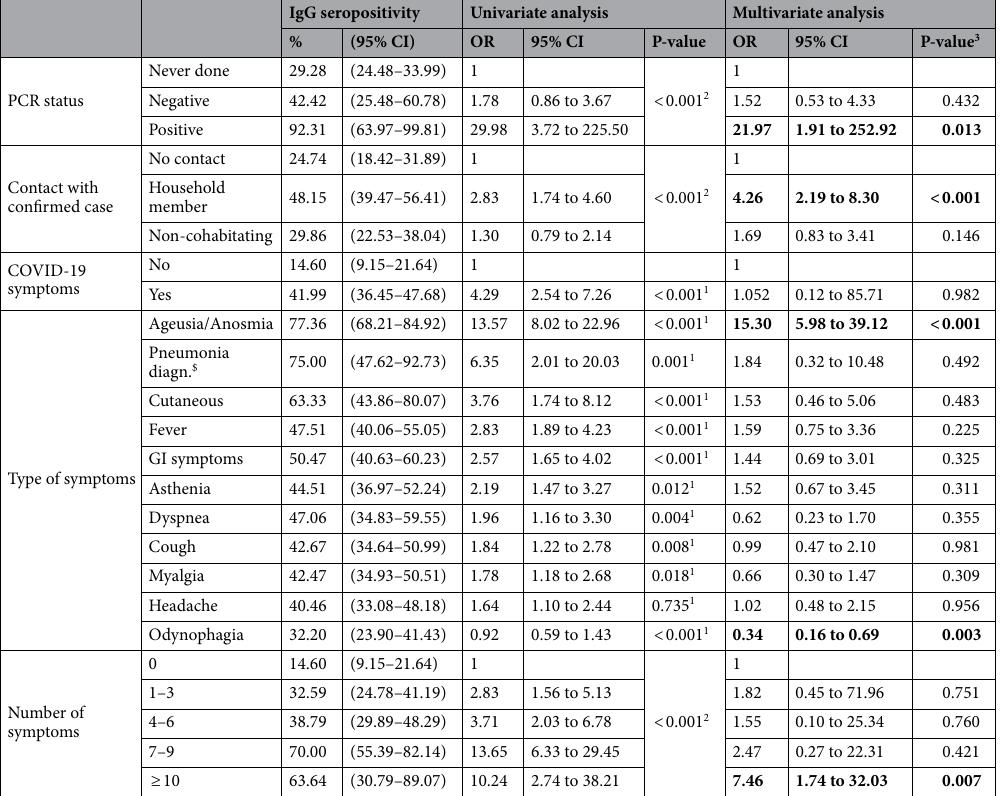
Table 3. SARS-CoV-2 IgG seropositivity by self-reported clinical characteristics. $ diagnosis. 1 Fisher’s exact test. 2 Chi-square test. 3 Enter multivariate logistic regression. Variables significantly associated with seropositivity are highlighted in bold. OR, Odds Ratio. 95% CI, 95% Confidence interval. GI,